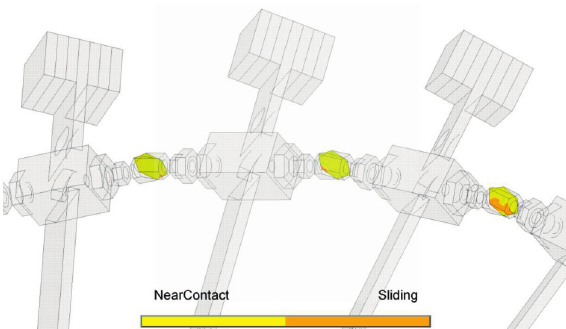
Figure 18: Detail of contact statuses (near contact and sliding) at tie-boss couplings 0.035995 s—6ND